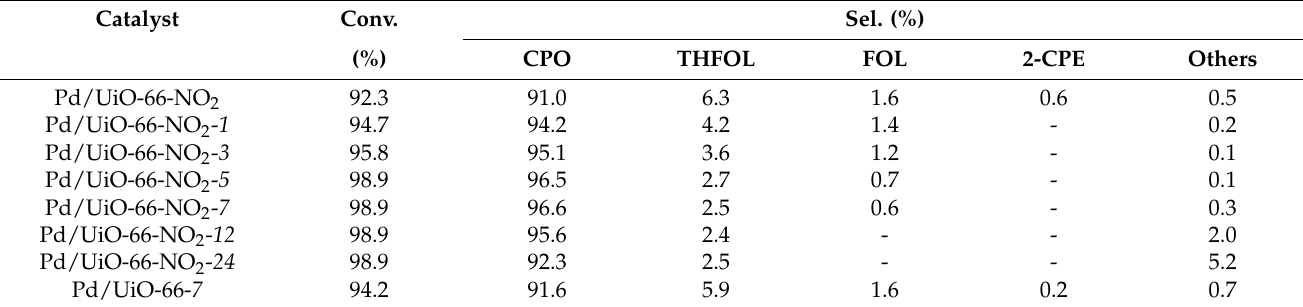
Table 3. Hydrogenative ring-rearrangement of FAL to CPO over Pd/UiO-66-NO 2 - t and Pd/UiO-66- 7 .